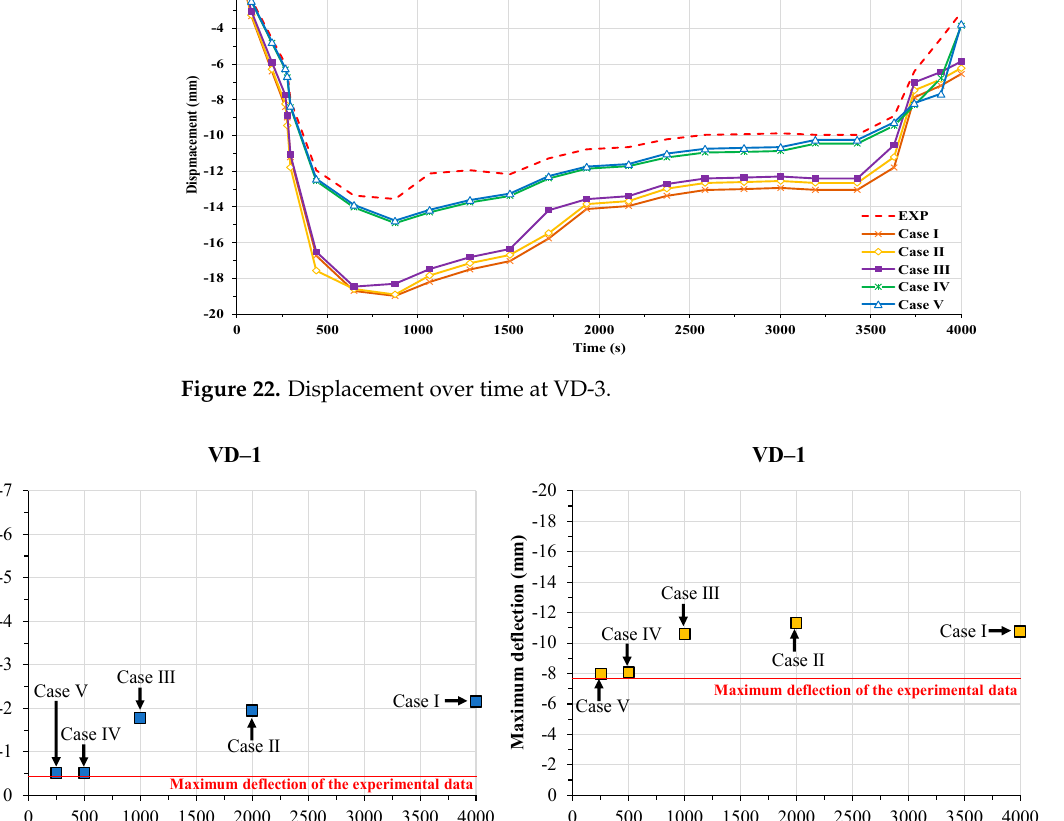
Figure 23. Deflection at 4000 s and maximum deflection versus time increments ( ∆ t ) at VD-1.